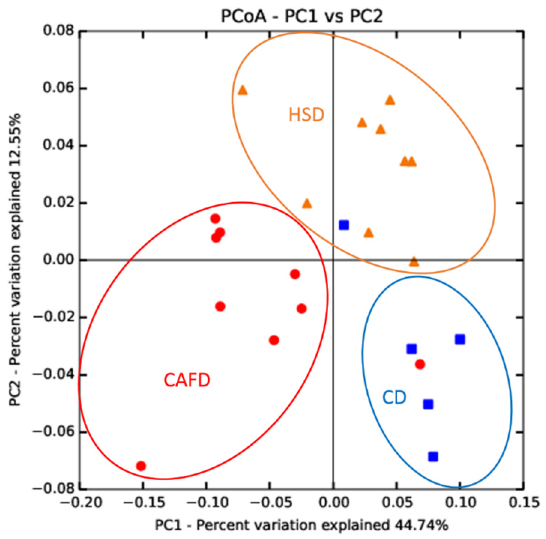
Figure 5. Graphical representation of the principal Component Analysis comparison of the microbiota in the 23 male Wistar rats.